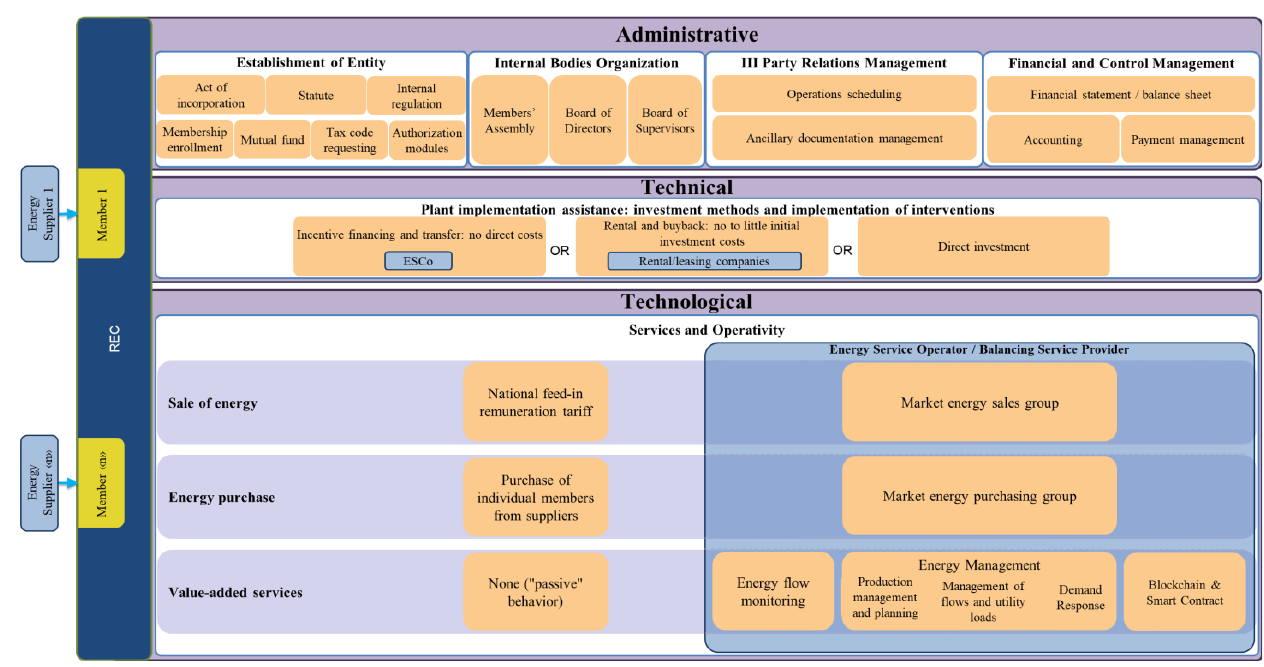
Figure 10. REC realisation framework.